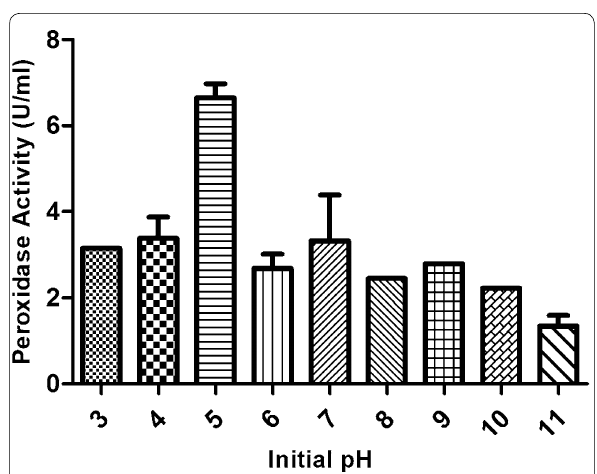
Fig. 1 Initial medium pH for optimum peroxidase activity expression by BMAB-1